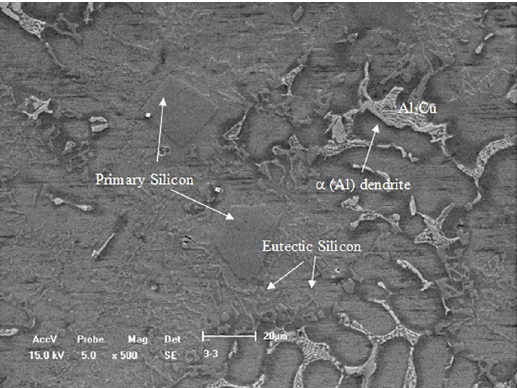
Figure 1. SEM image of A390-0.3wt%Nd alloy